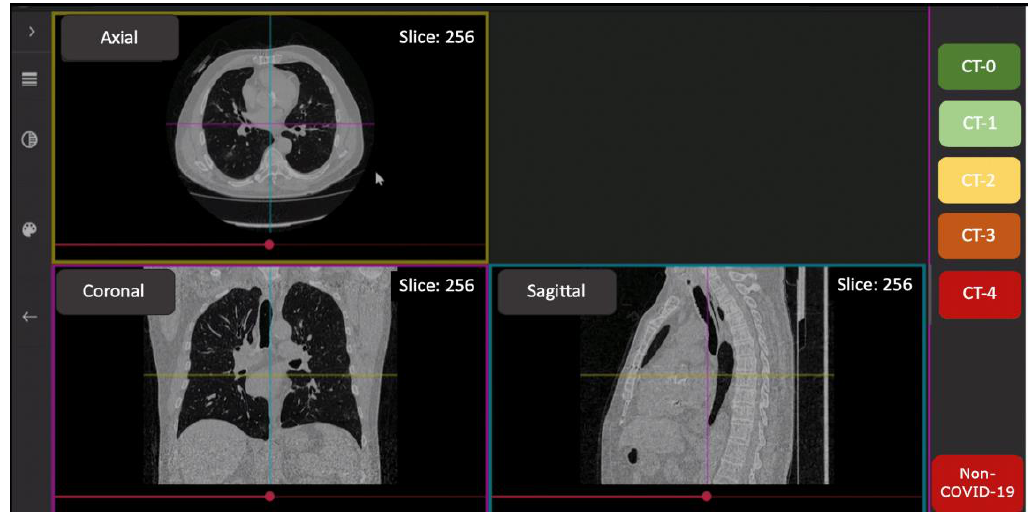
Figure 1. The interface of the FAnTom software tailored for CT0-4 grading. Each series was independently evaluated by two raters (Reader A and Reader B) blinded to the protocol used (standard- or low-dose CT, sharp or soft kernel) through the FAnTom interface.